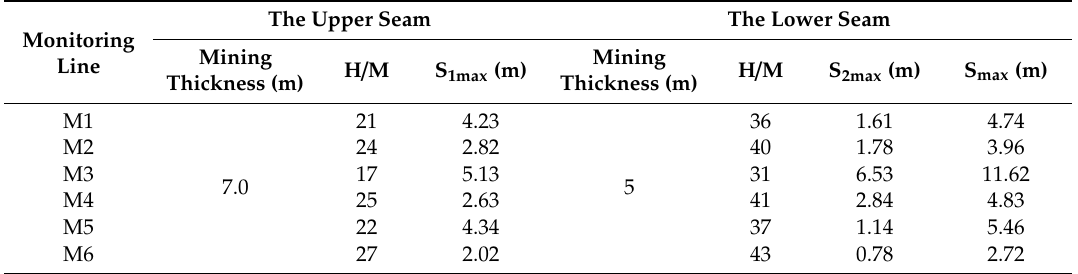
Table 6. Mining thickness, H / M and surface subsidence of two-seam mining in 6 monitoring lines. Monitoring